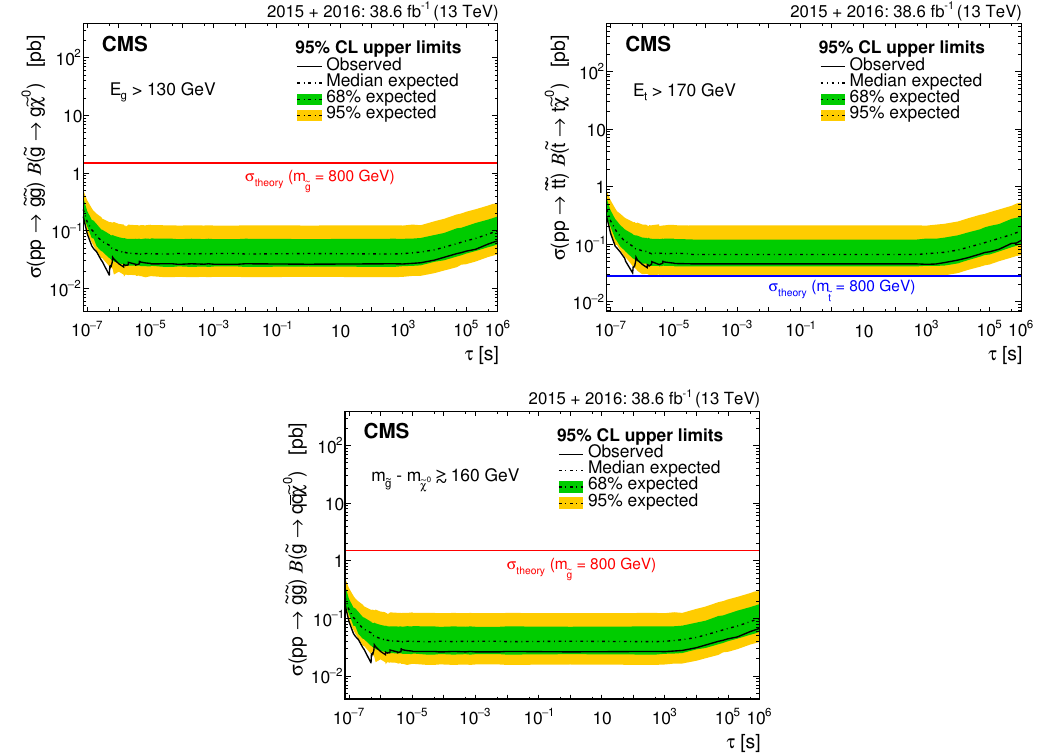
Figure 4 . The 95% CL upper limits on B (cid:27) for gluino and top squark pair production, using the cloud model of R-hadron interactions, as a function of lifetime, for combined 2015 and 2016 data for the calorimeter search. We show gluinos that undergo a two-body decay (upper left), top squarks that undergo a two-body decay (upper right), and gluinos that undergo a three-body decay (lower). The discontinuous structure observed between 10 (cid:0) 7 and 10 (cid:0) 5 s is due to the increase of the number of observed events in the search window as the lifetime increases. The theory lines assume B = 100%.